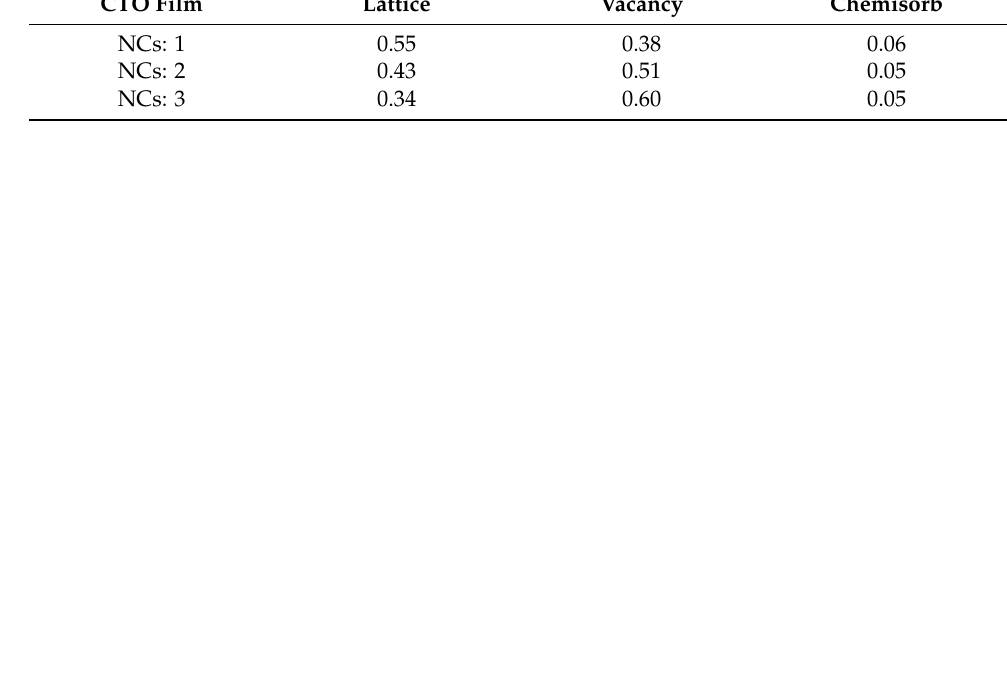
Figure 6. ( a ) UV–vis absorption spectra of NCs: 1, NCs: 2 and NCs: 3, ( b ) optical energy bandgap of NCs: 1, NCs: 2 and NCs: 3.